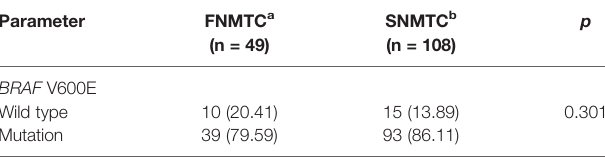
TABLE 5 | BRAF V600E mutations in FNMTC and SNMTC, n (%). Parameter